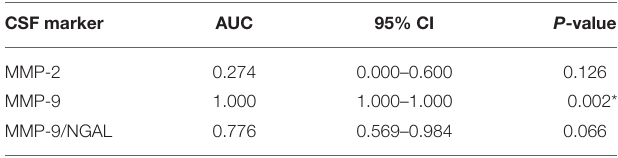
TABLE 2 | ROC Analysis of urinary biomarkers in predicting moyamoya disease. Biomarker